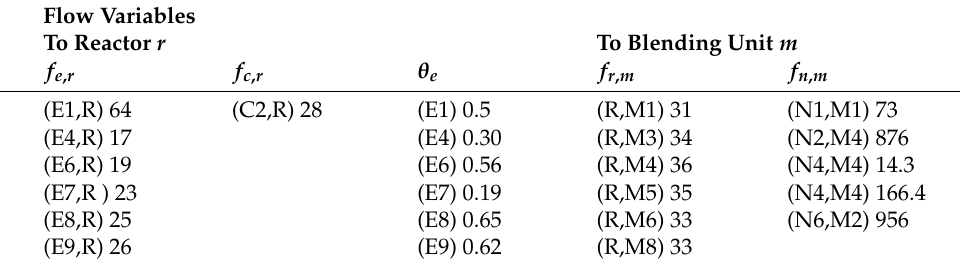
Table 2. Optimal operation decisions on flow rates for Case B.